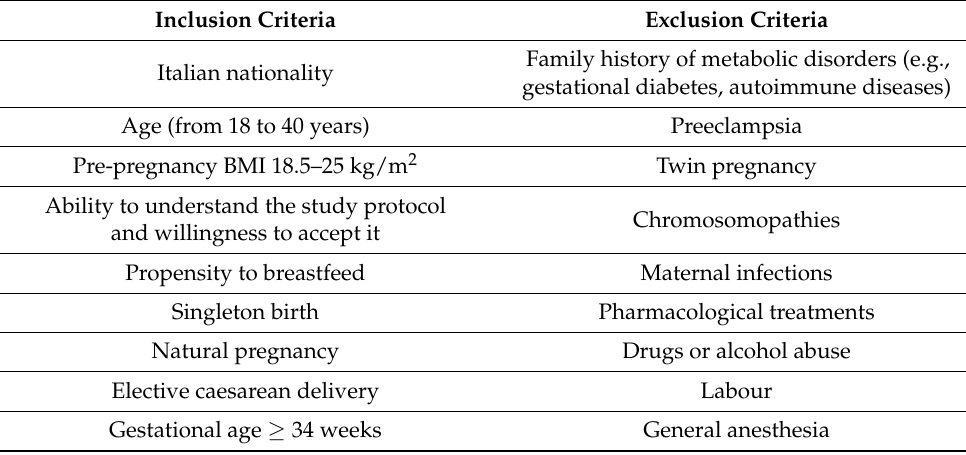
Table 2. Inclusion and exclusion